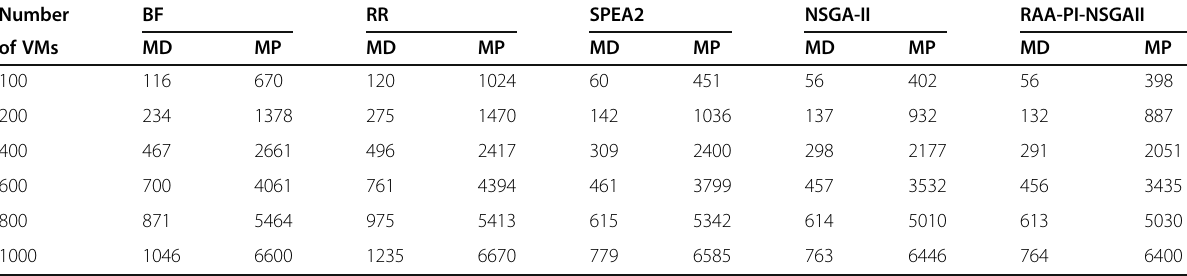
Table 4 Matching distances of resource performance and resource proportion